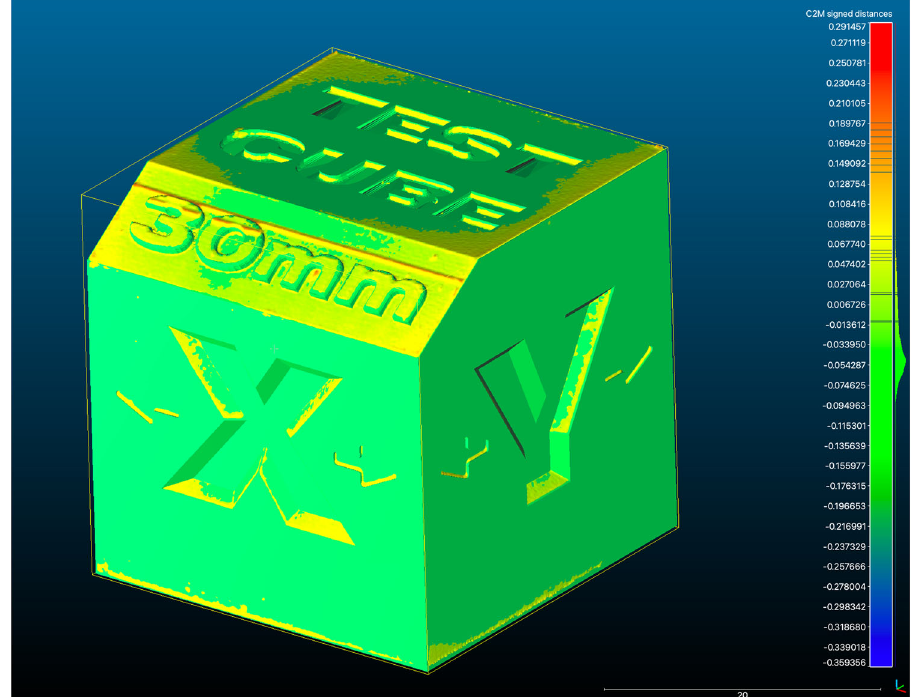
Fig. 2 CloudCompare colour map. An example of the scanned test object overlaid with Master STL which was performed for each measurement of each